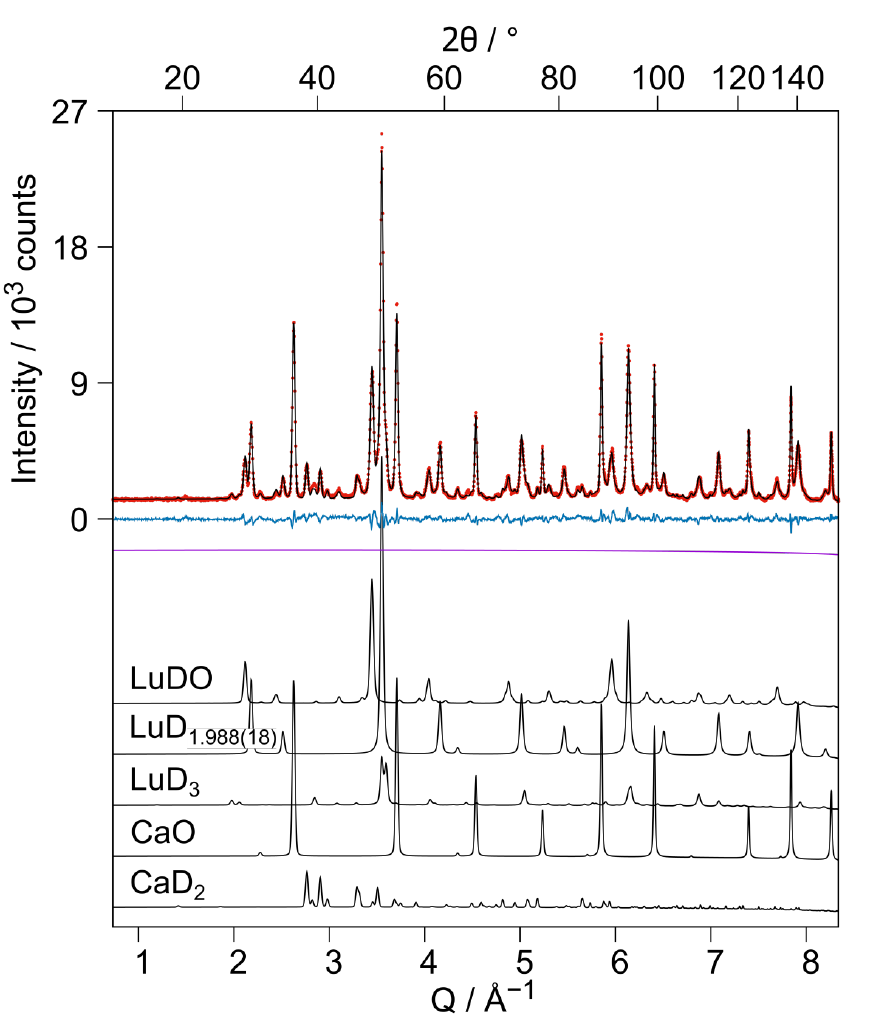
Figure 5. Rietveld refinement of the crystal structure of LuDO based on neutron diffraction data ( λ = 1.494 Å) and contributions of the included crystal structures (bottom). R wp = 5.18%, GoF = 2.5. Phase information: LuDO Pnma (24.8(3) wt%, R = 4.8%, a = 7.3116(16) Å, b = 3.6492(8) Å, F 2 c = 5.2021(7) Å), LuD 1.988(18) Fm 3 m (42.2(4) wt%, R = 2.6%, a = 5.02497(13) Å), LuD 3 P 3 c 1 (8.47(19) F 2 wt%, a = 6.1542(18) Å, c = 6.4064(10) Å), CaO Fm 3 m (19.73(11) wt%, a = 4.81183(6) Å), CaD 2 Pnma (4.84(11) wt%, a = 5.9497(7) Å, b = 3.5987(5) Å, c = 6.8046(9) Å. Red dots: measurement meas , black curve: calculation calc , blue curve: difference meas-calc , purple curve: